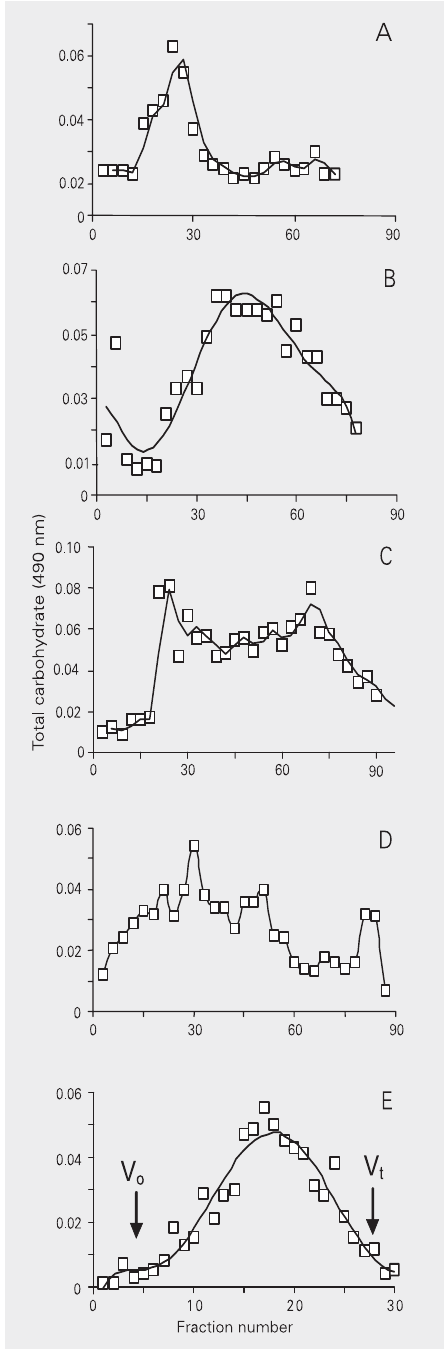
Figure 2. Gel filtration chromatography on Sepharose 4B of the 4 M KOH fraction of walls from Rhynchely- trum repens and maize. A , Young leaves; B , ex- panded leaf blade; C , sheath; D , stem of Rhynchely- trum repens ; E , maize (standard). V 0 = void volume obtained using blue dextran 2000; V t = total volume obtained using